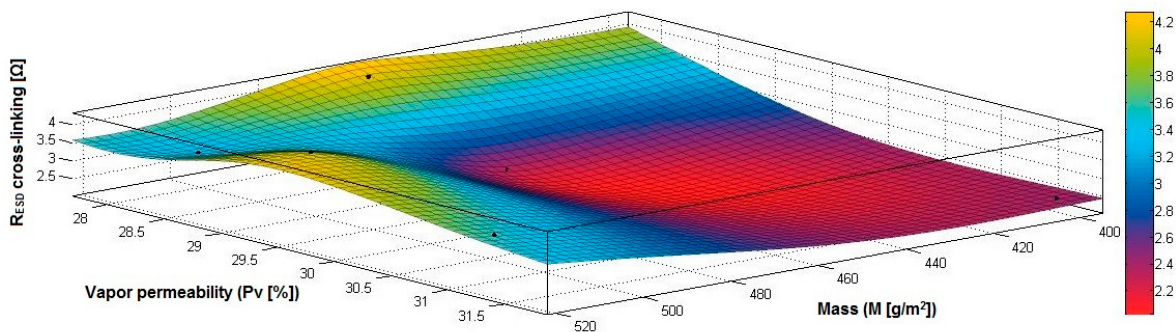
Figure 42. 3D representation R ESD after crosslinking = f(M, Pa) samples preliminarily treated in RF plasma O 2 using RF 2 generator and power 50 W.